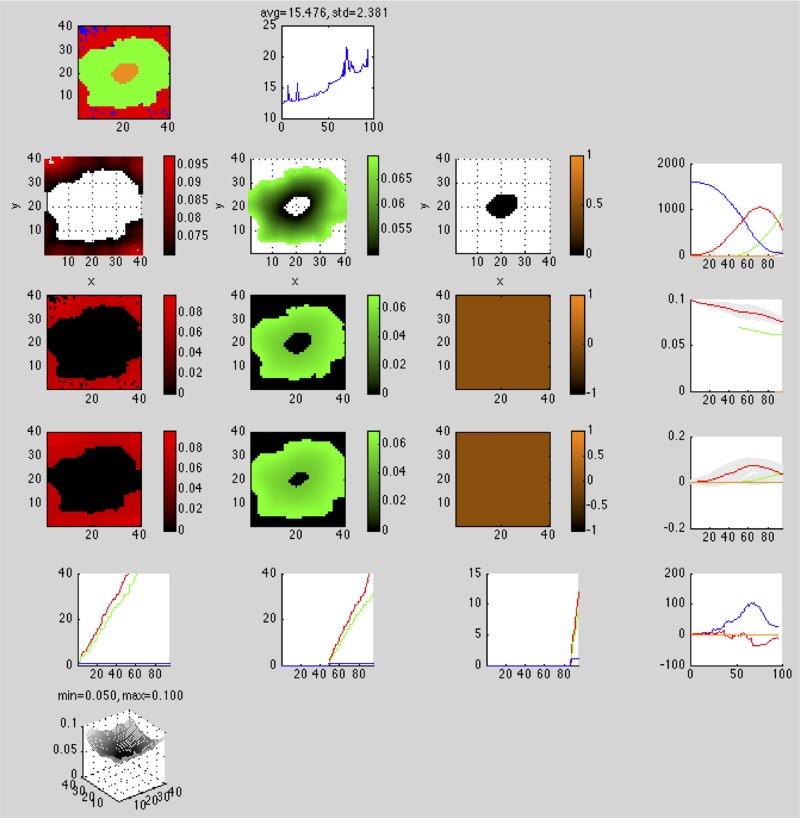
2D simulation console.Simulator console displaying an evolving necrotic core in a 40 × 40 lattice. The simulation consists of four cell types—empty (blue), viable (red), hypoxic (green), and necrotic (orange)—and one particle type, O2. In row 1, column 1, the cell population at this point in the simulation consists of all cell types. In rows 2-5, columns 1-3, all cell types except empty have fitness and other spatial statistics reported. In row 6, the concentration of O2 is reported. In column 4, rows 2-5, aggregate cell type statistics are reported in time series.